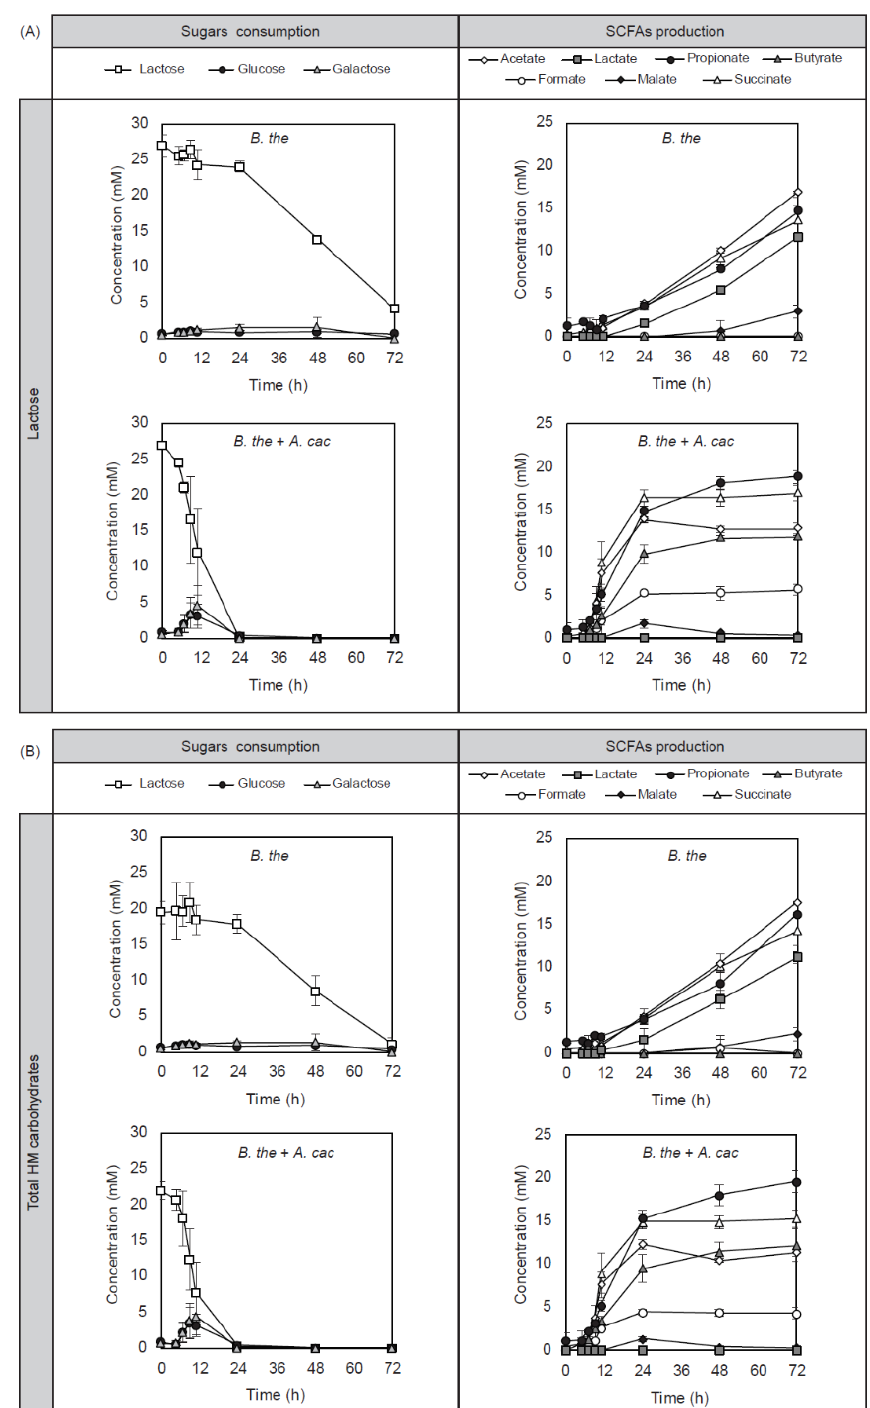
Figure 2. B. thetaiotaomicron supported butyrate production of A. caccae in the early-life carbohydrates. The sugar and short-chain fatty acid (SCFA) composition of B. thetaiotaomicron monocultures and co-cultures with A. caccae in basal medium containing ( A ) lactose or ( B ) total HM carbohydrates. Error bars represent the standard deviation for biological triplicates. No metabolite production was detected for A. caccae monoculture in the identical medium (Table S1).